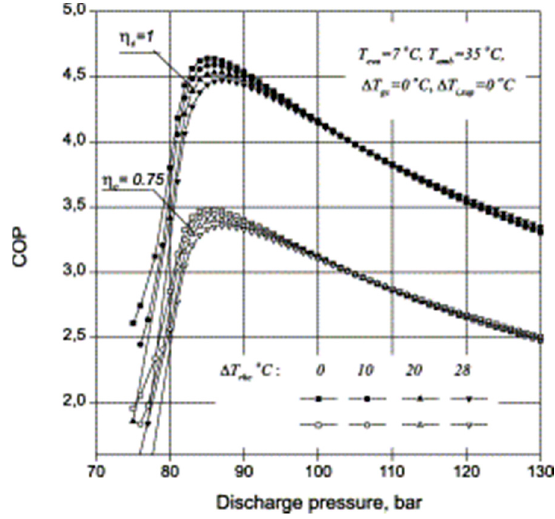
Figure 3. Effect of discharge pressure on the system COP. Reproduced with permission from [26]. Elsevier, 2001.